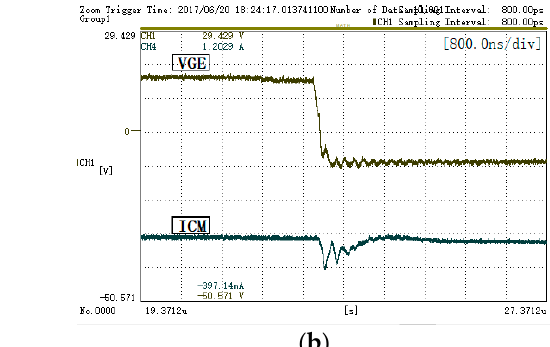
Figure 18. Turn-on common mode current. ( a ) GaN, ( b ) IGBT.